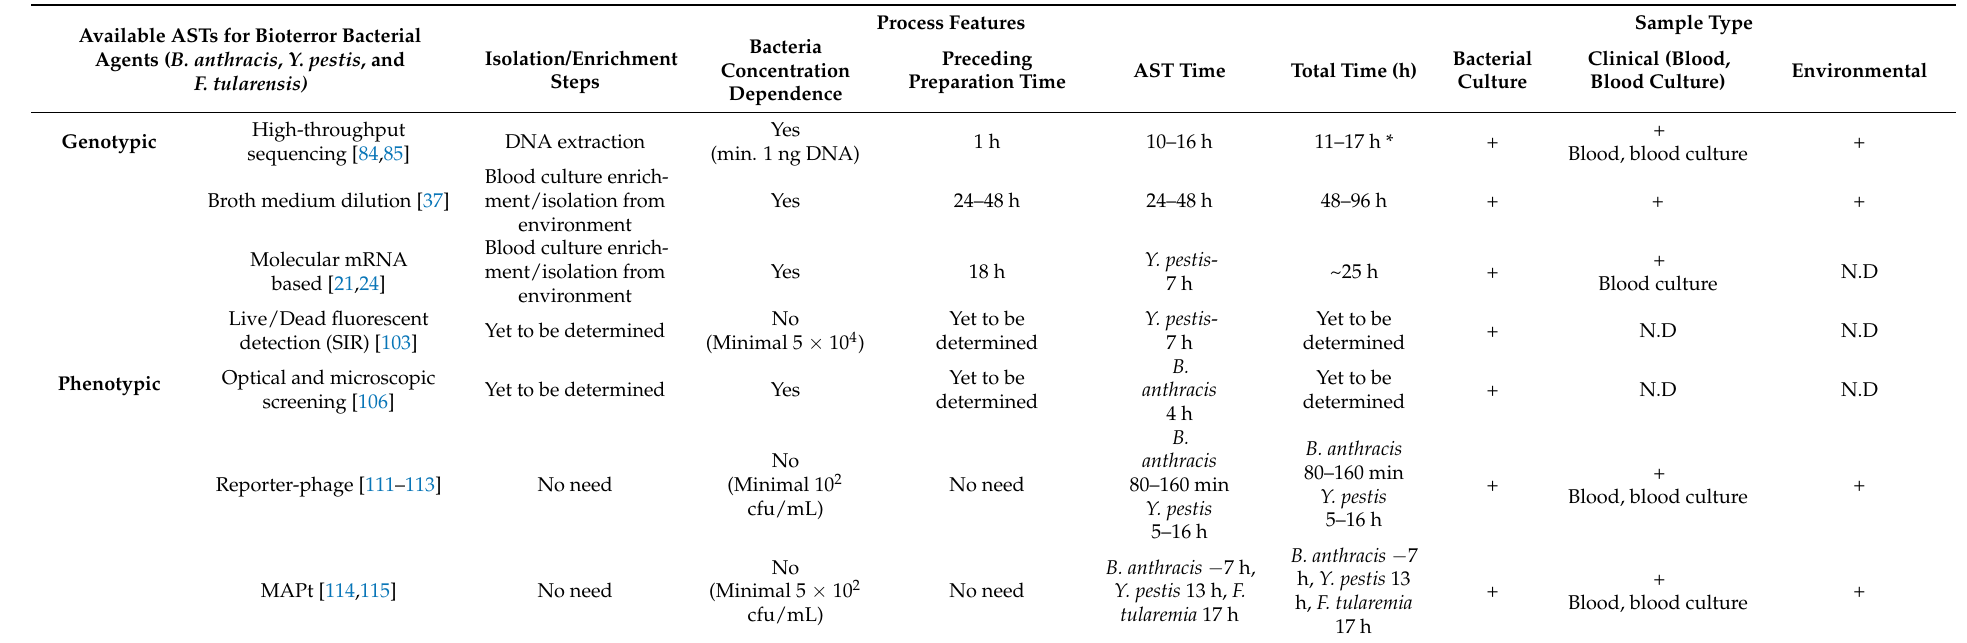
Table 1. ASTs implemented on Tier-1 bioterror bacterial agents.